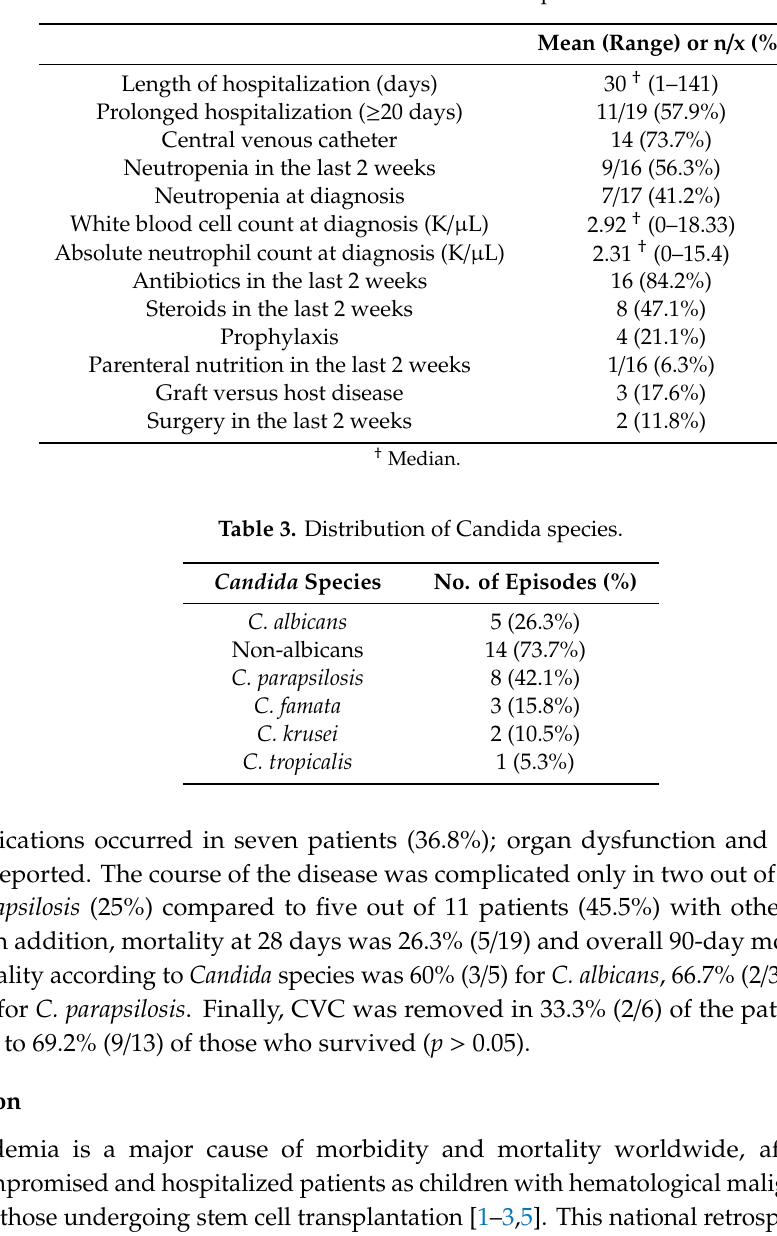
Table 2. Clinical characteristics and risk factors of patients with candidemia.